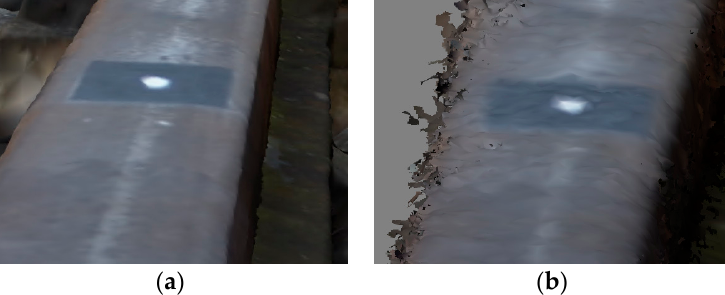
Figure 6. Fragment of generated 3D mesh model of, e.g., left rail (solid view) in RealityCapture ( a ) and PhotoScan ( b ) software.